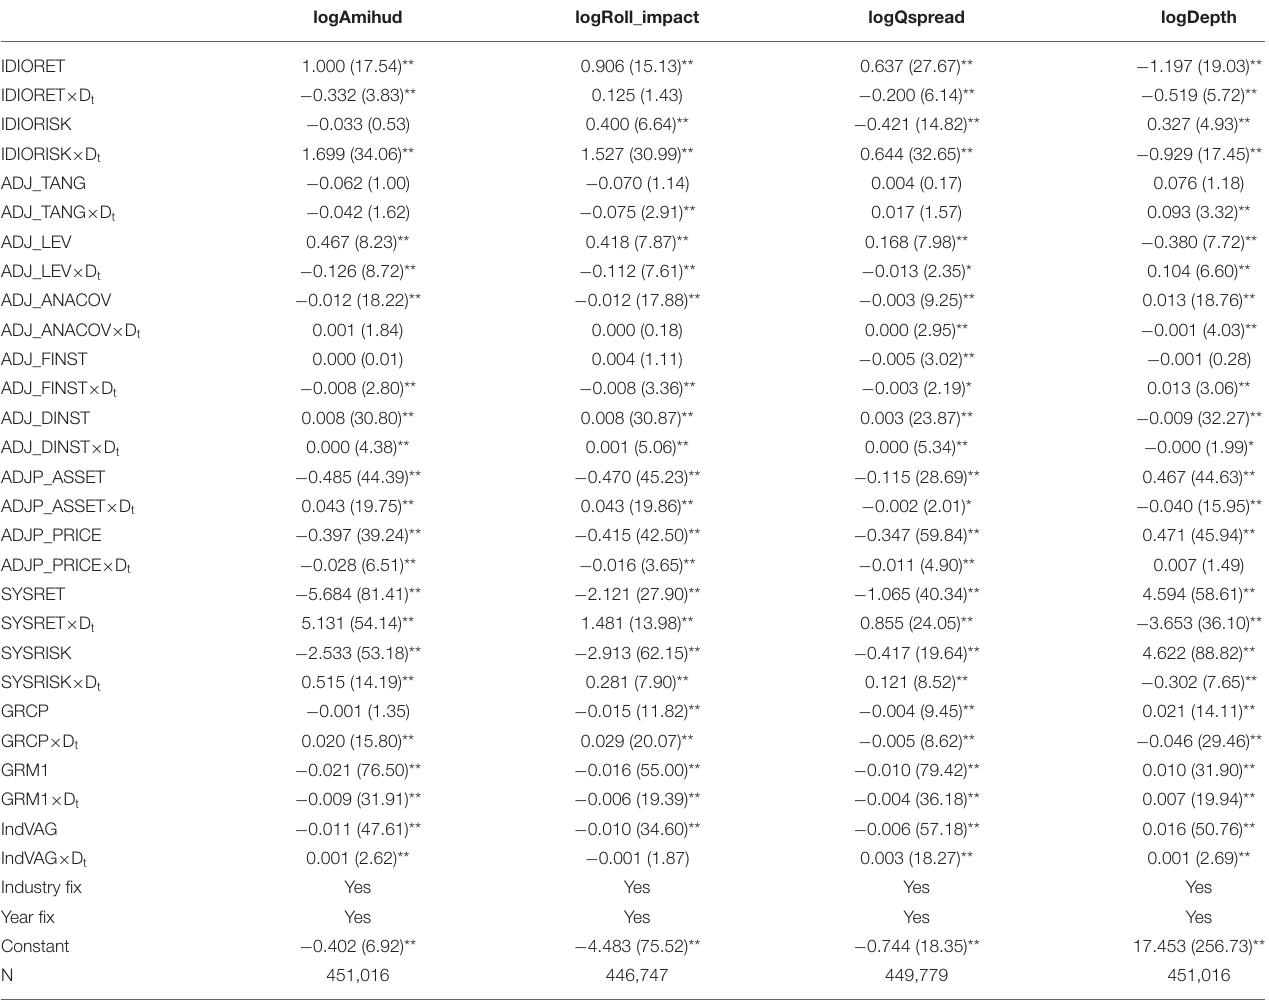
TABLE 4 | The sensitivity of stock liquidity to contemporaneous determinants under different EPU levels. logAmihud logRoll_impact logQspread logDepth IDIORET 1.000